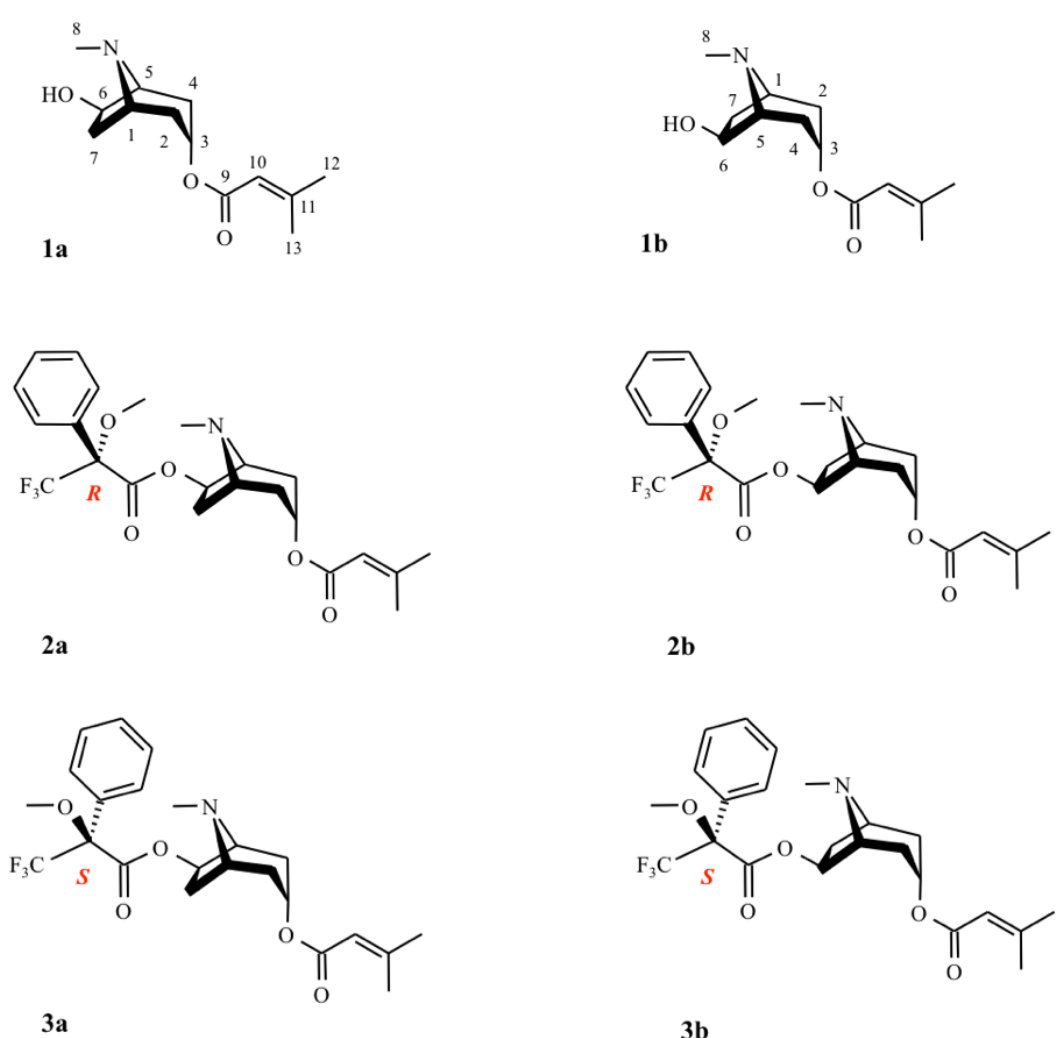
Figure 2. Structures of 3 α -senecioyloxy-6 β -hydroxytropane 1 and its ( R )- and ( S )-Mosher’s esters 2 and 3